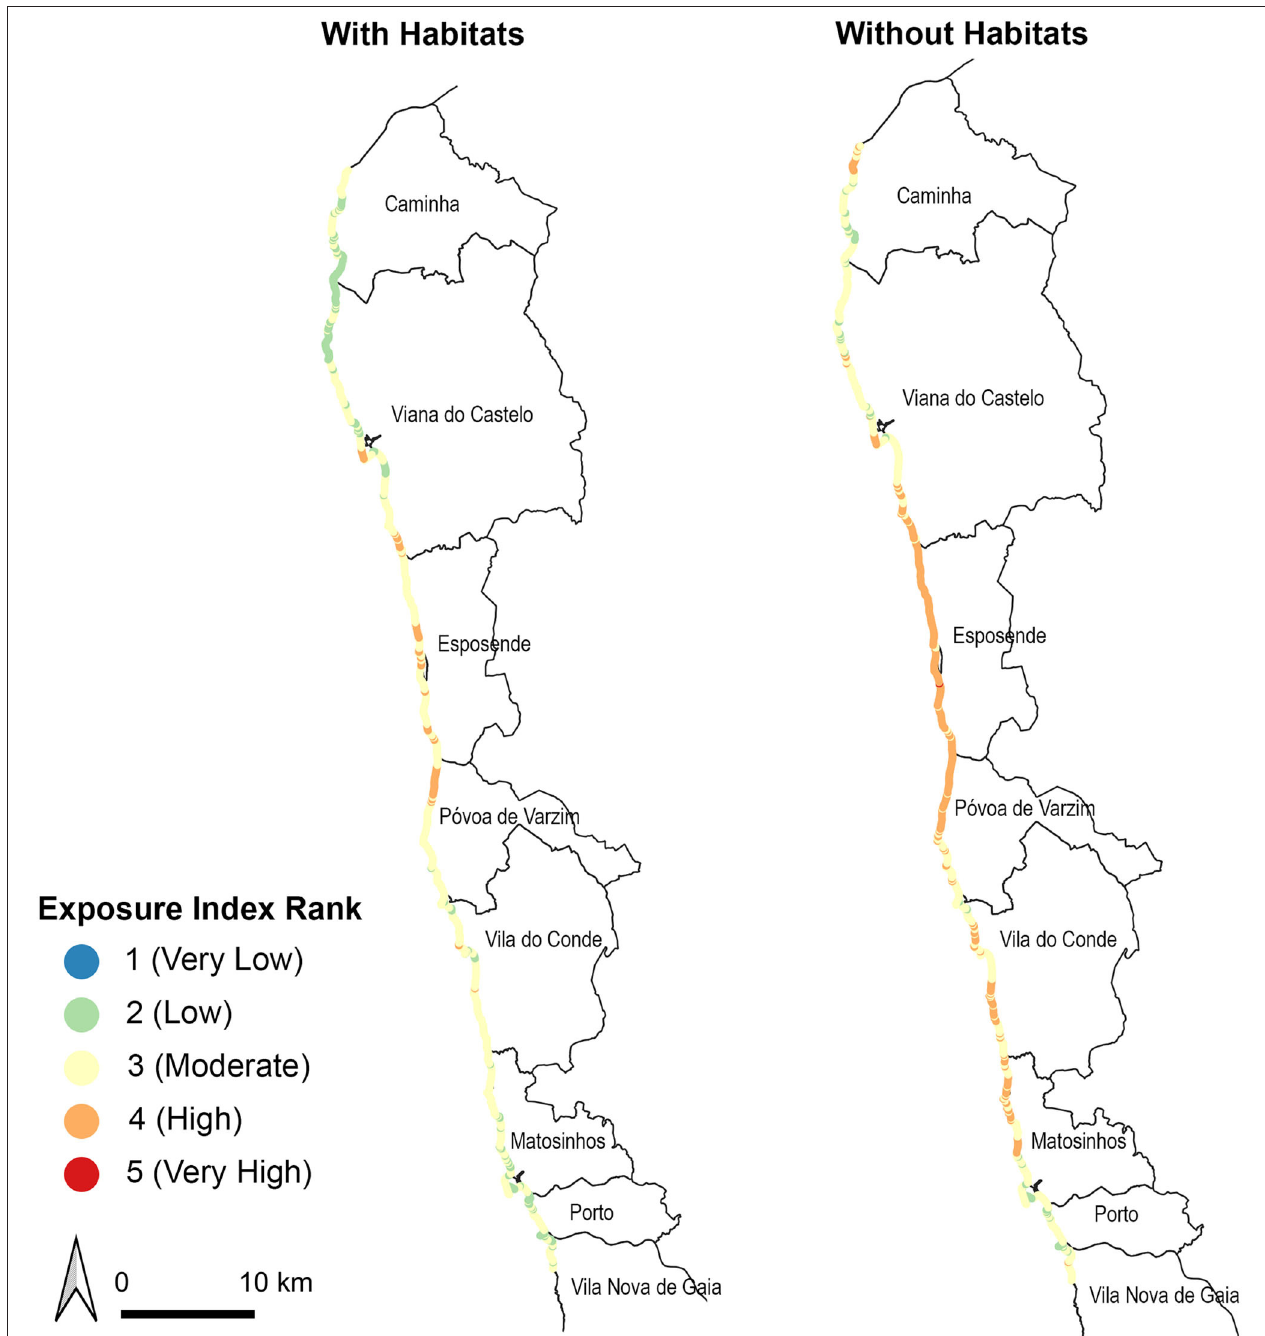
FIGURE 2 | Exposure Index values under the Current with habitats (right) and no habitats (left) scenarios, across the northern coast of